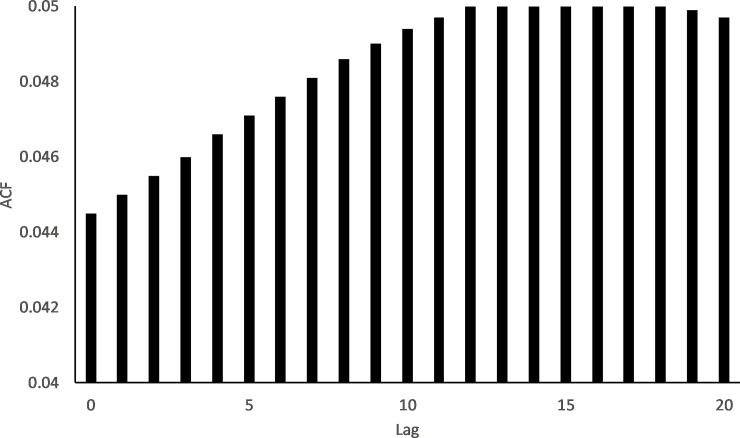
Cross-correlation between tide height and depth measured at the 250m below bund location.Maximum correlation occurs at a lag of 12 to 17 which is equivalent to a 3 to 4.25 hr delay between tides experienced at the coast and measured changes in depth at the 250m below bund location– 15 min data records. 95% CI has been omitted from the graph falling at ± 0.05.